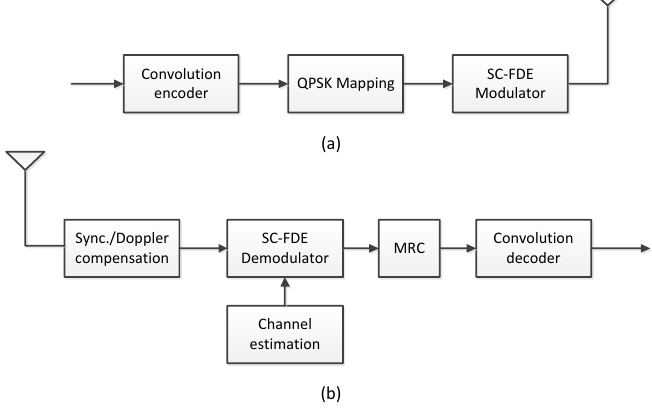
Figure 1. Block diagram: ( a ) transmitter and ( b )